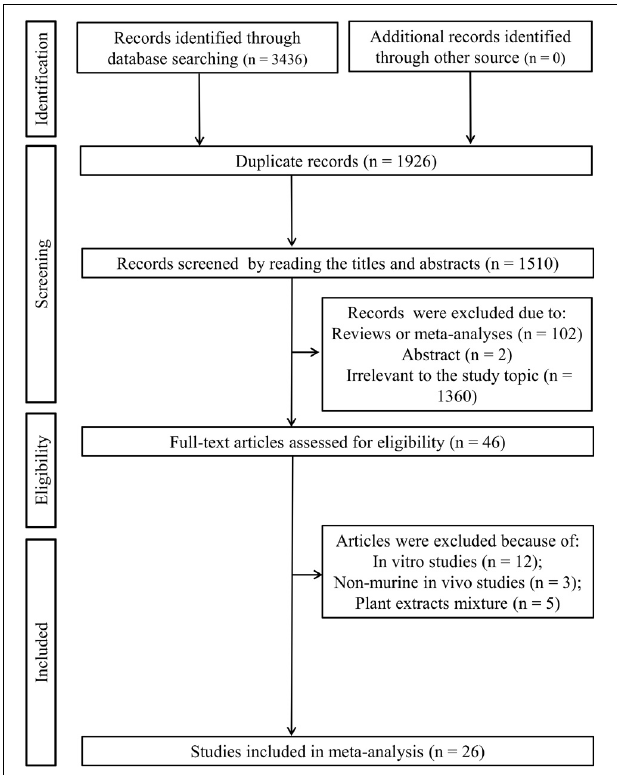
FIGURE 1 | Flow chart of the literature